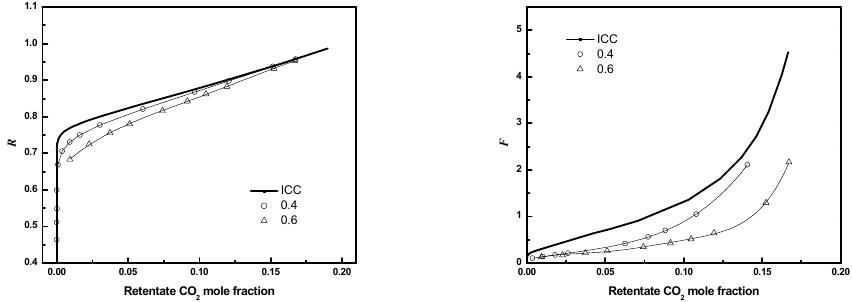
Figure 17. R or F as a function of CO 2 mole fraction for module with different packing fraction (3-D) ( N = 405, D/R f = 3; circle: φ = 0.4; up triangle: φ = 0.6; solid line: ICC).